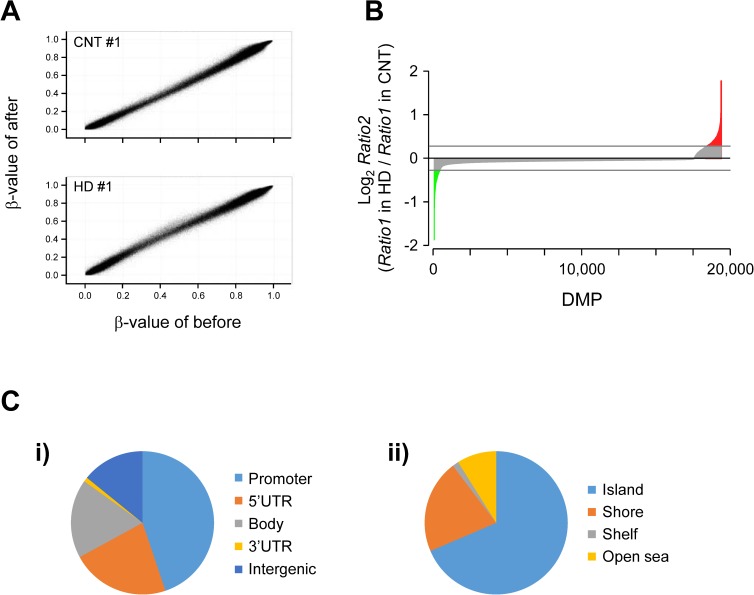
The hyper- or hypo-methylated positions induced by milk product intake during IWT in whole blood cells.A: DNA methylation levels of CpG sites identified by the Infinium 450K methylation assay. Typical examples of normalized β-values before vs after training in a CNT subject and an HD subject, which were used to determine the ratio (Ratio1) of the β-value after training to that before training in each CpG site. B:
Ratio2 on a base-2 logarithmic scale (y) plotted against 19,371 differentially methylated CpG positions (DMPs) after training in the HD group (n = 12) compared with the CNT group (n = 12) (x). Ratio2 indicates the ratio of the median value of Ratio1 for the HD group to that for the CNT group at each DMP. The number of DMPs on the x-axis is an arbitrary unit, which was ranked by the Ratio2 values. The upper and lower areas of the gray lines in the figure indicate the Ratio1 values of the HD that group are >1.2-fold higher (indicated by red) and lower (indicated by green) than that of the CNT group, respectively. C: Pie chart displaying the genomic location of the 1,448 positions in which more hyper- or hypo-methylation occurred in the HD group than in the CNT group by >1.2-fold in relation to genes (i) and CpG (ii) context.